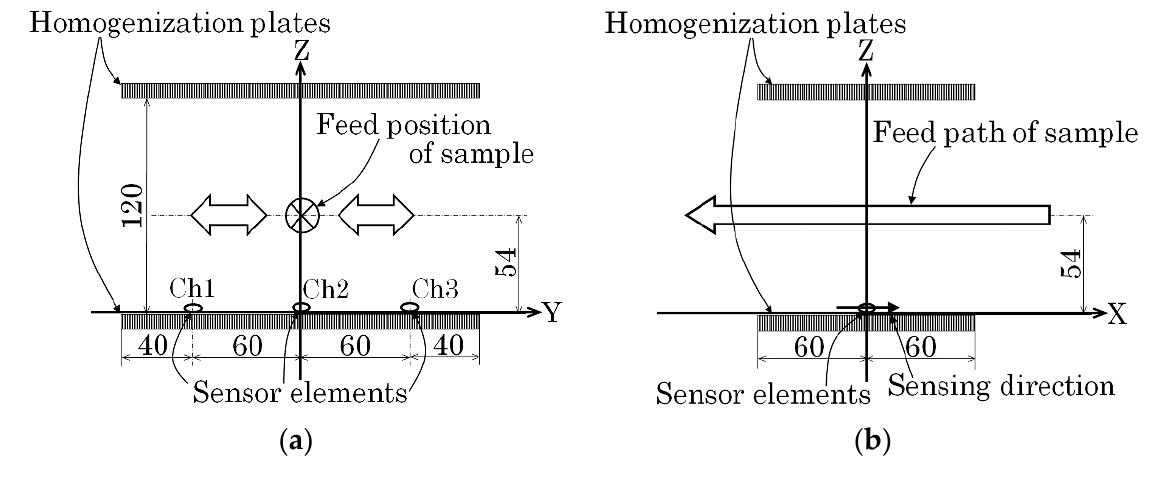
Figure 20. Schematic representation of the measurement layout (second experiment). ( a ) Front view (View point of feeding sample). ( b ) Side view.